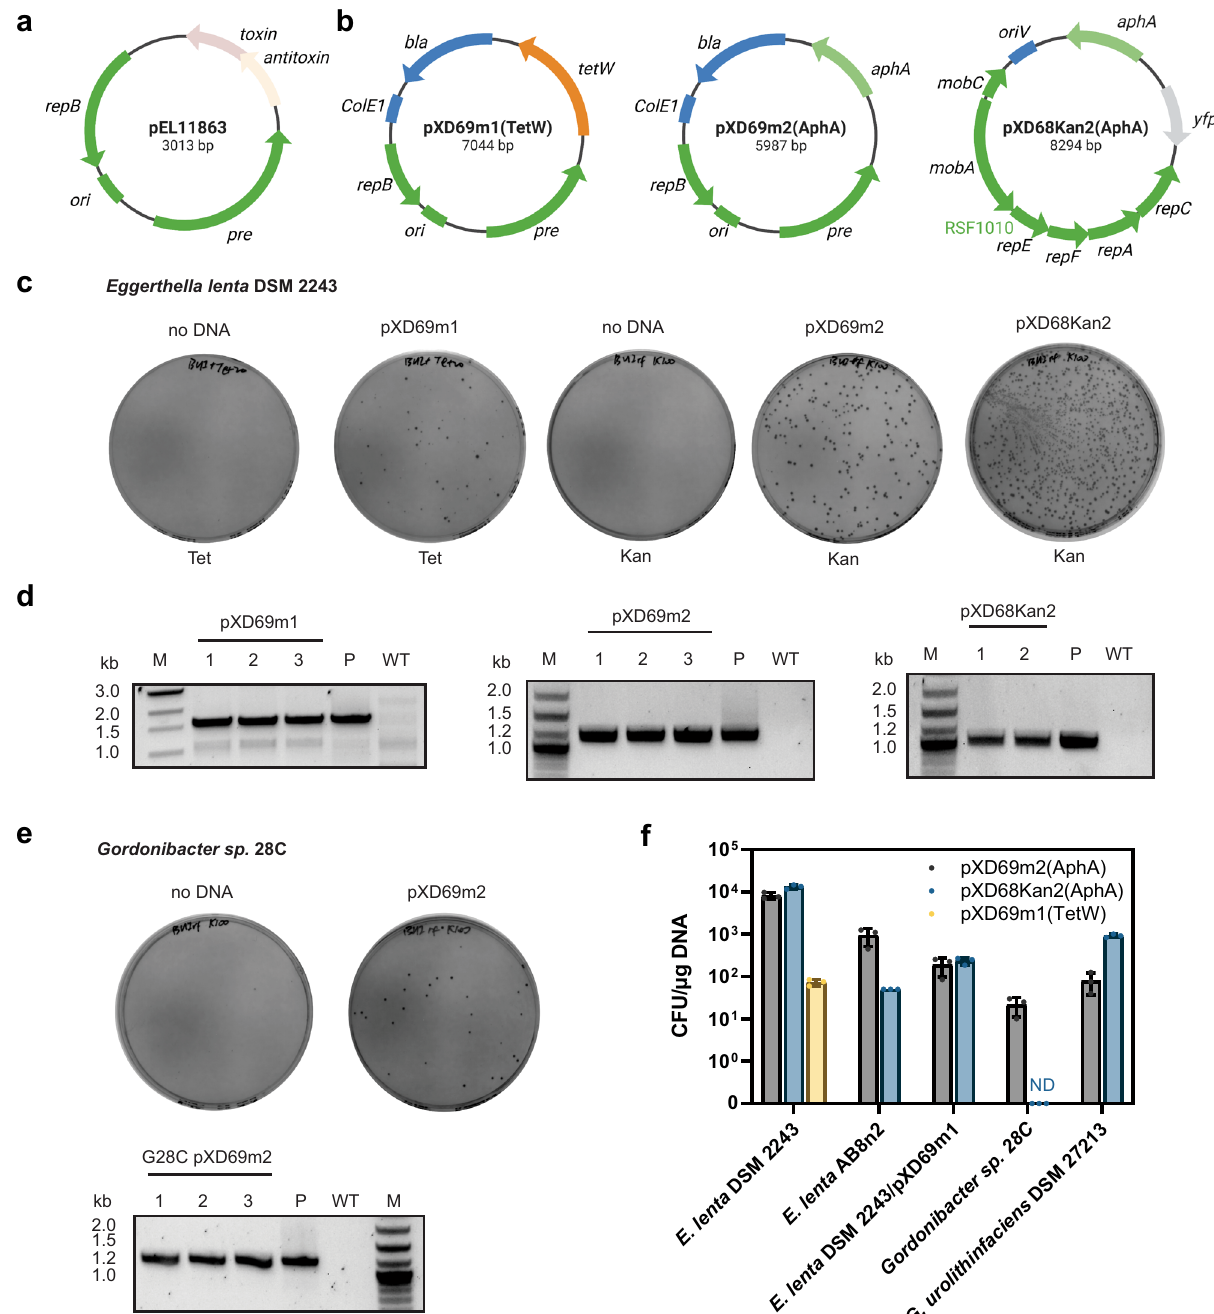
Fig. 1 | Engineering of an E. lenta endogenous plasmid enables ef fi cient trans- formation of E. lenta and Gordonibacter . a An E. lenta endogenous plasmid pEL11863 was chosen for further engineering. b Construction of shuttle plasmids pXD69m1 and pXD69m2, and the broad-host-range plasmid pXD68Kan2. Shuttle plasmids pXD69m1 and pXD69m2 were constructed by assembly of E. lenta pEL11863 replicon (dark green), E. coli ColE1 origin and bla ampicillin-resistance gene (blue), and E. lenta antibiotic resistance gene tetW (orange) or aphA (light green). pXD68Kan2 was constructed from RSF1010-based broad host-range plas- mid pAM5409, with antibiotic resistance gene replaced by aphA , and the RSF1010 replicon (dark green) and yfp (grey) originally on pAM5409 were retained.